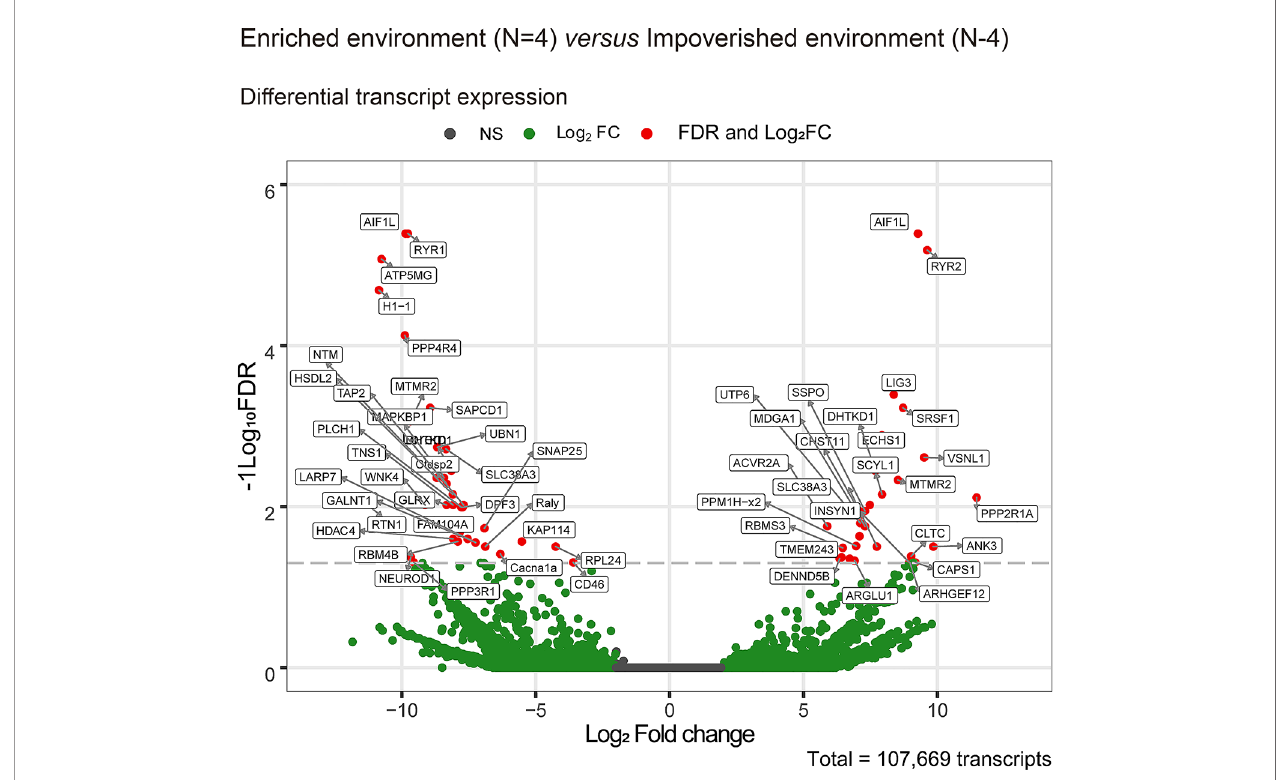
FIGURE 10 | Volcano plot of differentially expressed transcripts in IE and EE groups of Colossoma macropomum individuals. Middle compacted grey dots represent non-signi fi cant differential expression, green dots indicate transcripts that were differentially expressed for fold change, and red circles, above grey dotted line, correspond to differentially expressed transcripts ( − 1 < logFC > 1 and − 1Log 10 FDR < 0.05). FDR indicates the false discovery rate (rate of false events; p values corrected for multiple